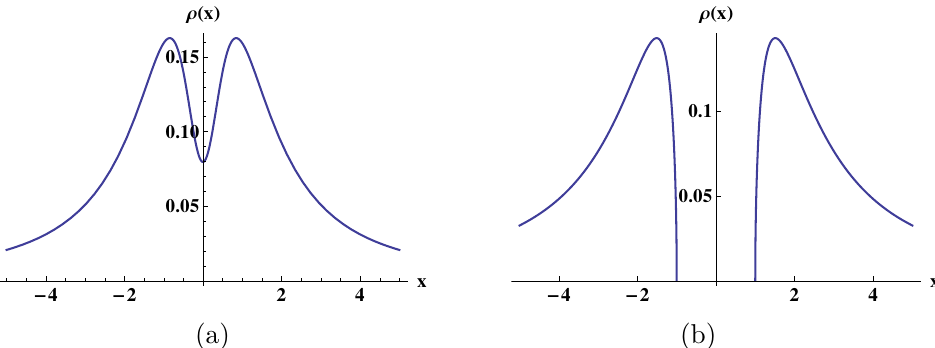
Figure 6 . Eigenvalue densities in the marginal case τ = 1 . The phase transition occurs at κ c = 2 . (a) Subcritical case with κ = 1 . 5 . (b) Supercritical case with κ = 4